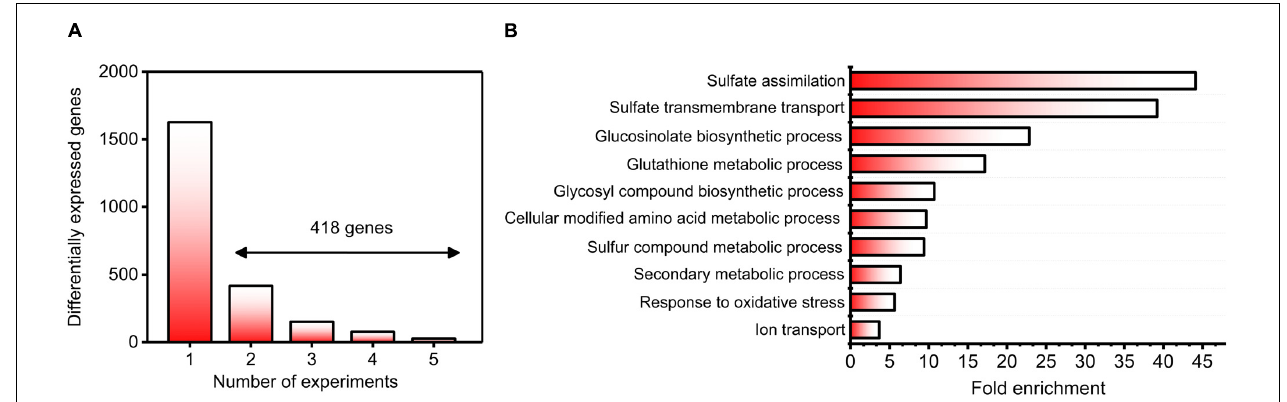
FIGURE 1 | Identification of robust genes and biological functions involved in the sulfate response. (A) Histogram of 2046 significantly responding sulfate-responsive genes (FDR < 5%) distributed according to the number of experiments in which they were regulated. Those genes regulated by sulfate in at least two different experiments (418) were selected for further analyses. (B) The most enriched biological processes associated with genes regulated by sulfate availability. The GO over-representation analysis was carried out using 418 genes regulated by sulfate in at least two different experiments, and a 5% FDR cutoff was used. The top 10 GO terms are shown ranked in accordance with their enrichment